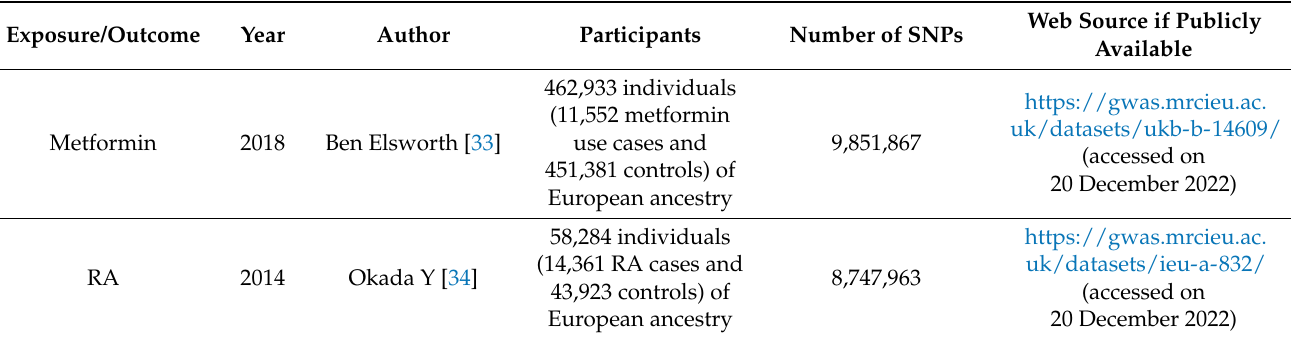
Table 1. Source of the GWAS data for metformin and